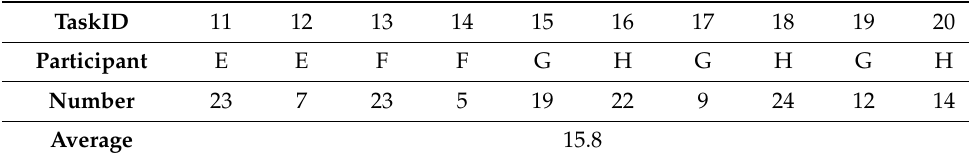
Table 3. Number of conceptions in the LAM non-use group.